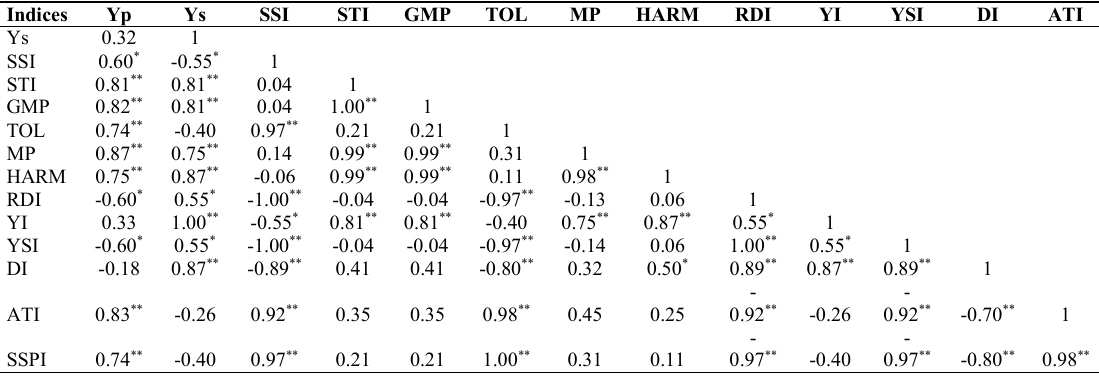
Table 7. Correlation coefficients between studied zinc resistance indices in durum wheat ( Triticum durum